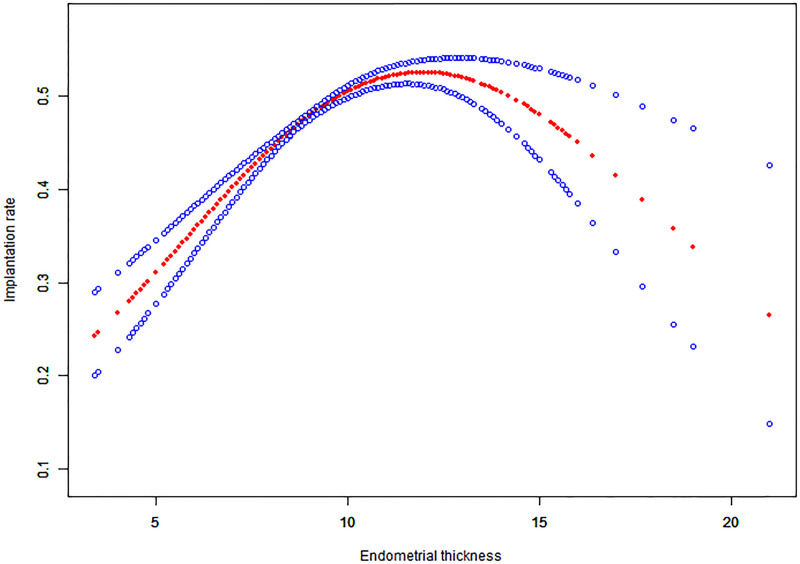
Associations between endometrial thickness and implantation rate of HRT-FET cycles.The threshold was identified, and a nonlinear association between endometrial thickness and the implantation rate was found (P<0.001) using a generalized additive model (GAM). The solid-dotted red line represents the smooth curve that fits between variables. Blue curves represent the upper and lower limits of the 95% CI. All were adjusted for age, the duration of infertility, body mass index, infertility type, and the number and type of embryos transferred.